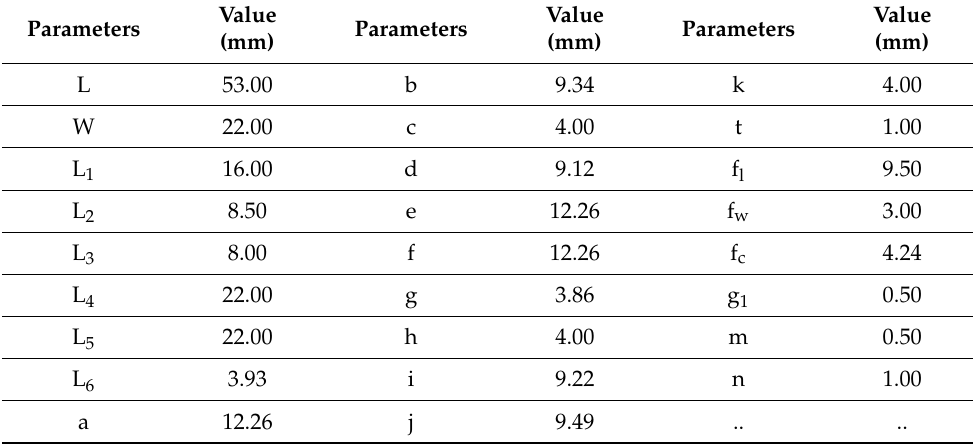
Table 1. The designed parameters of 3D antenna